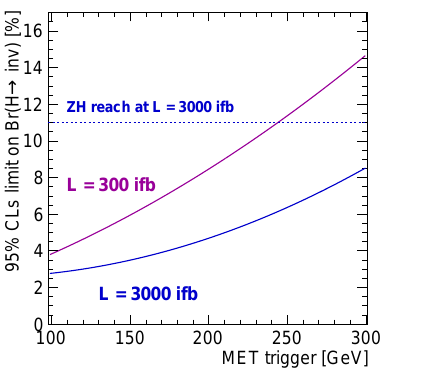
Figure 8: CLs limits on invisible Higgs decays from weak boson fusion, as a function of trigger cuts on missing transverse energy (left) or the transverse momentum of the tagging jets (right), compared to the expected reach in the leptonic Zh channel. Figures from Ref [ 127 ]